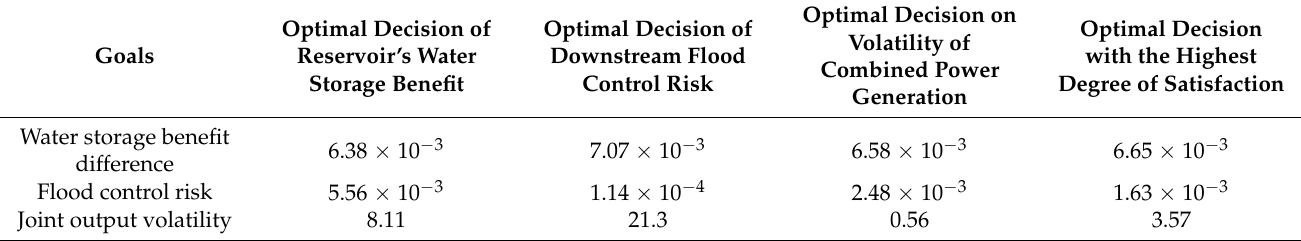
Table 2. Comparison of optimal solutions.